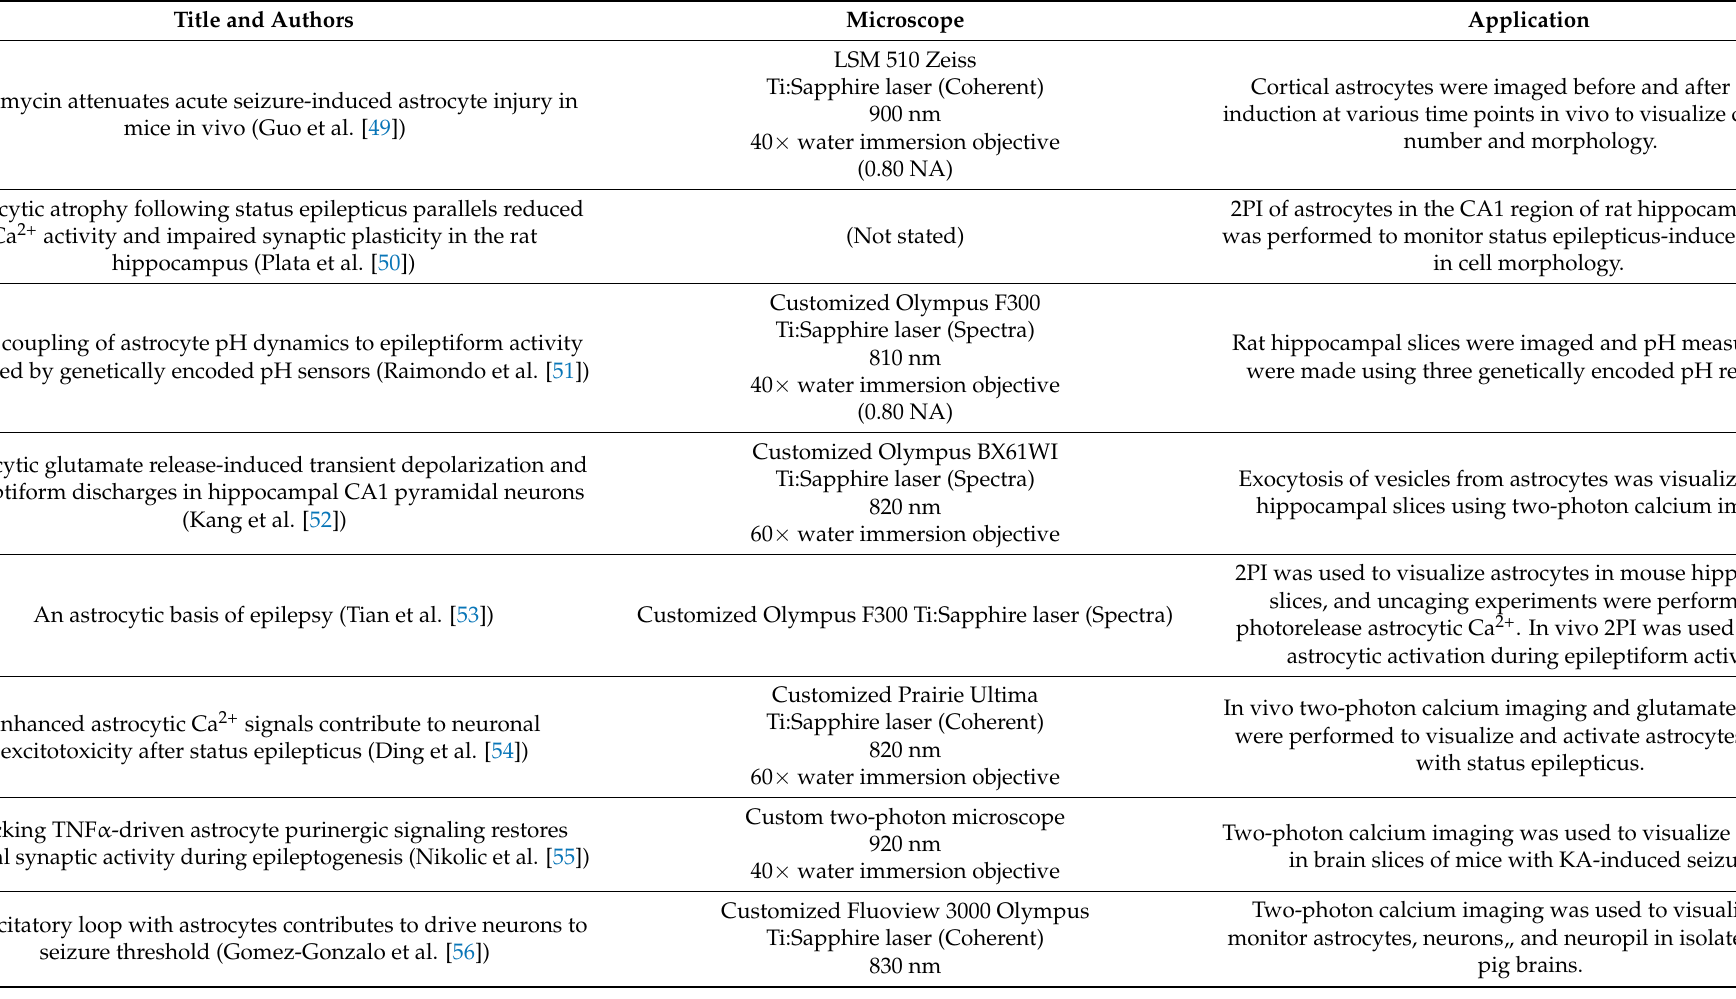
Table 3. Astrocytes—data abstraction table catalogues the type of two-photon microscope used and how 2PI was applied in each study within this group of